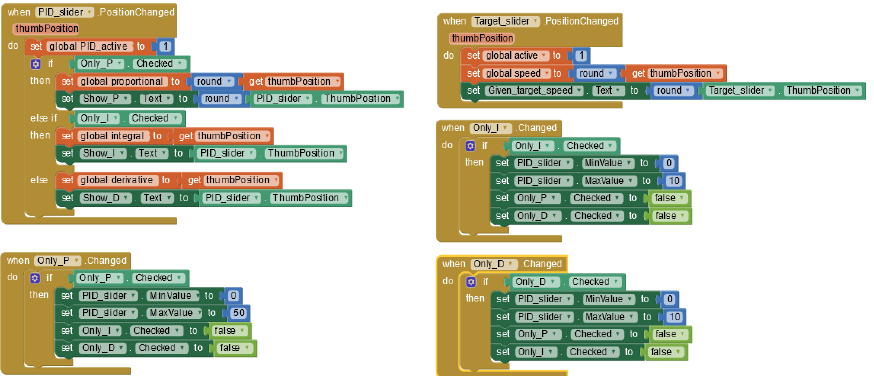
Figure 5. An indicative code part composed using the MIT App Inventor.